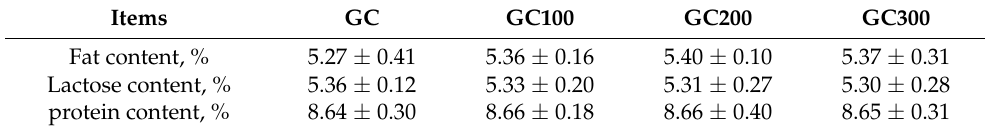
Table 3. Effects of SI and APS mixture on colostrum composition of lactating